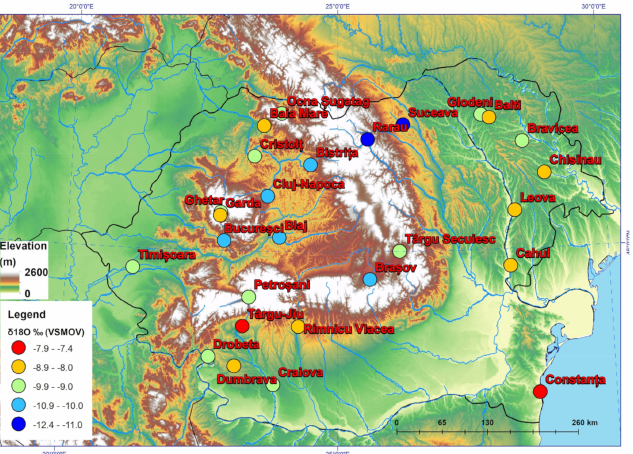
Figure 5. Spatial distribution of the mean δ 18 O values over the analyzed period in Romania and the Republic of